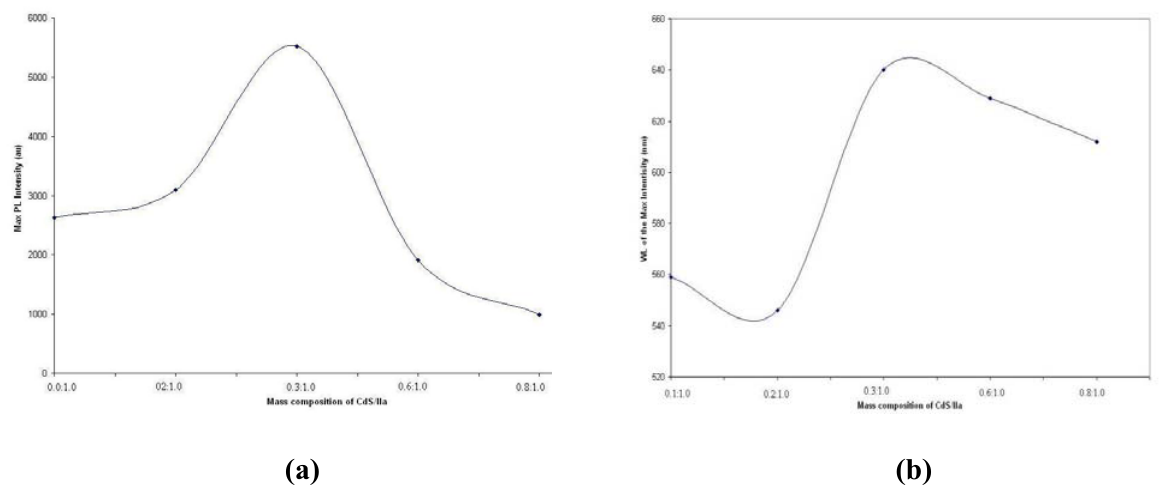
Figure 12. (a) The maximum intensities against various mass compositions; (b) The wavelength of the maximum intensity against various mass compositions for nanocomposites IIa